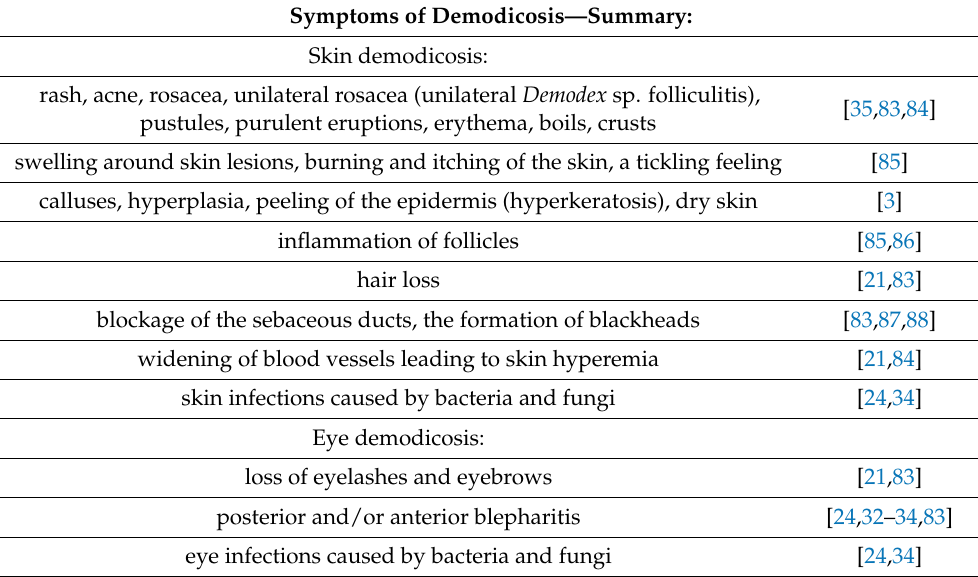
Table 2. The most common clinical presentations of demodicosis. Symptoms of Demodicosis—Summary: Skin